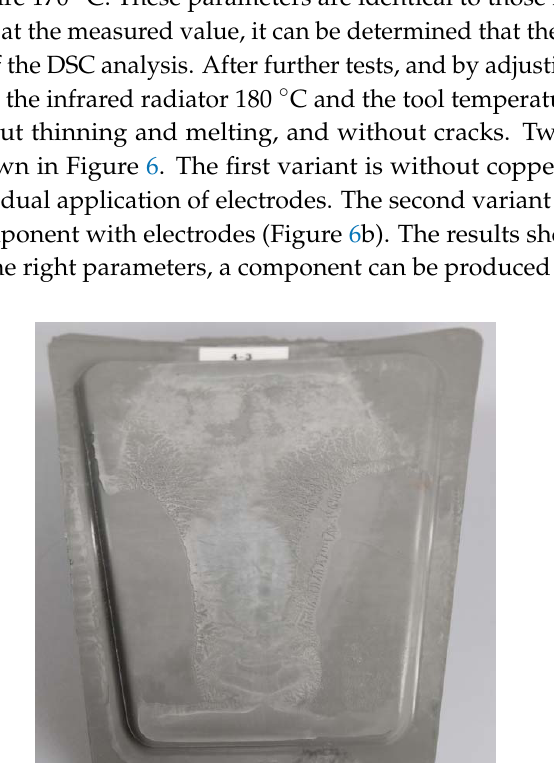
Figure 6. Formed hybrid laminates with sensor functionality in two versions: ( a ) without electrodes and ( b ) with electrodes at preheating temperature 180 °C and tool temperature 150 °C. For activating the sensor effect of the hybrid laminate, a polarization process has to be conducted (Figure 1, label 4). Due to the extrusion, joining, and forming temperatures, which are higher than the Curie temperature of the PZT component, the piezoceramic particles depolarize during these processes. Therefore, the functionalized hybrid laminate must be polarized after the forming process. Based on previous experiments, the polarization process was conducted at elevated temperatures, between 100 °C and 120 °C [24]. In this temperature range, it is possible to polarize the piezoceramic layer during the cooling phase, after forming the hybrid part. By using this procedure, the residual heat of the forming process renders the reheating for polarization redundant. This approach has great potential for saving energy and resources, as well as for reducing cycle times during the fabrication process of multifunctional lightweight structures based on hybrid laminates.